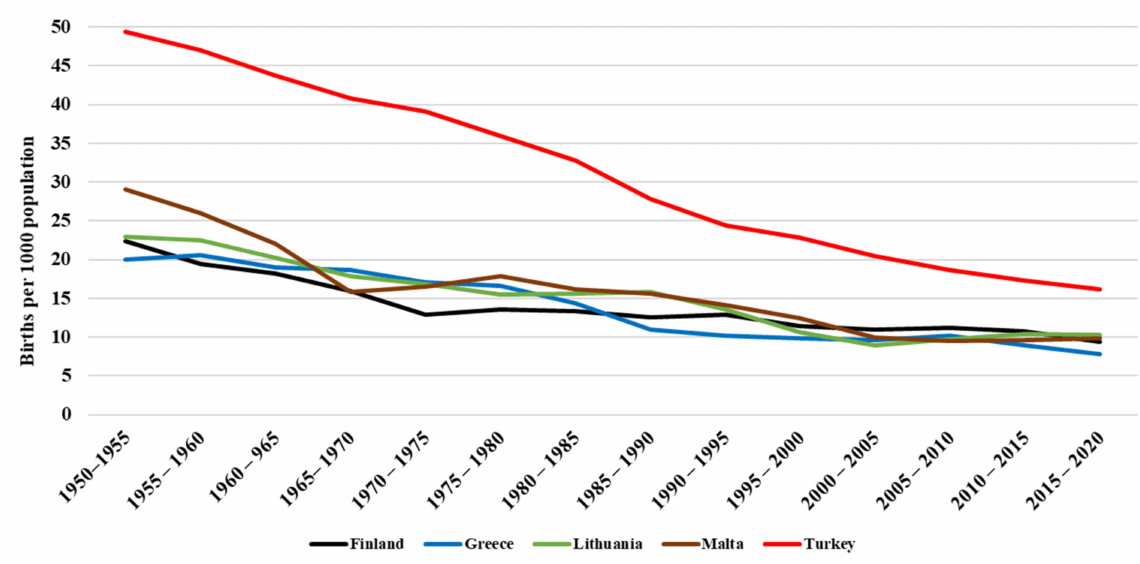
Figure 1. Birth rate by country in 1950–2020 (births per 1000 population). Source: [32].